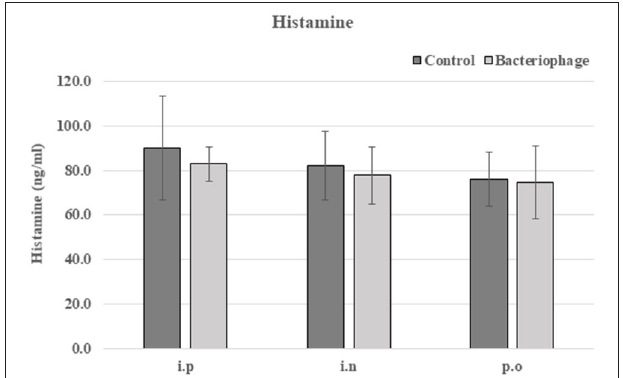
Supplementary Figure 1 | Histamine levels in sera from mice treated with phages using three different routes, intraperitoneal (i.p), intranasal (i.n), or oral (p.o). The experiment was performed in triplicate. * P < 0.05, ** P <